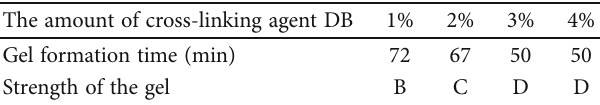
Table 3: The in fl uence of cross-linking agent DB on gel.